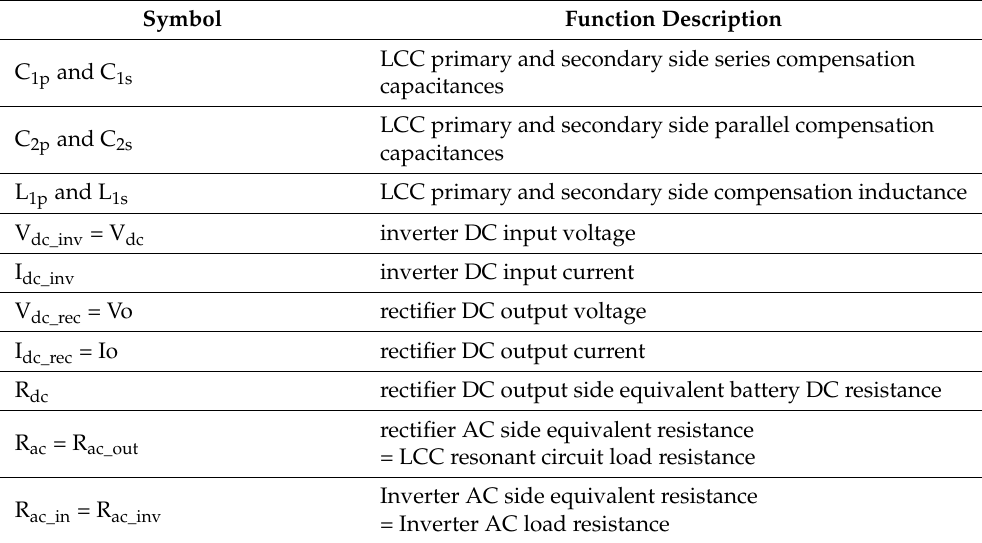
Figure 1. Wireless charging DAB LCC Resonant DC/DC resonant converter. Table 1. DAB LCC resonant converter circuit notation